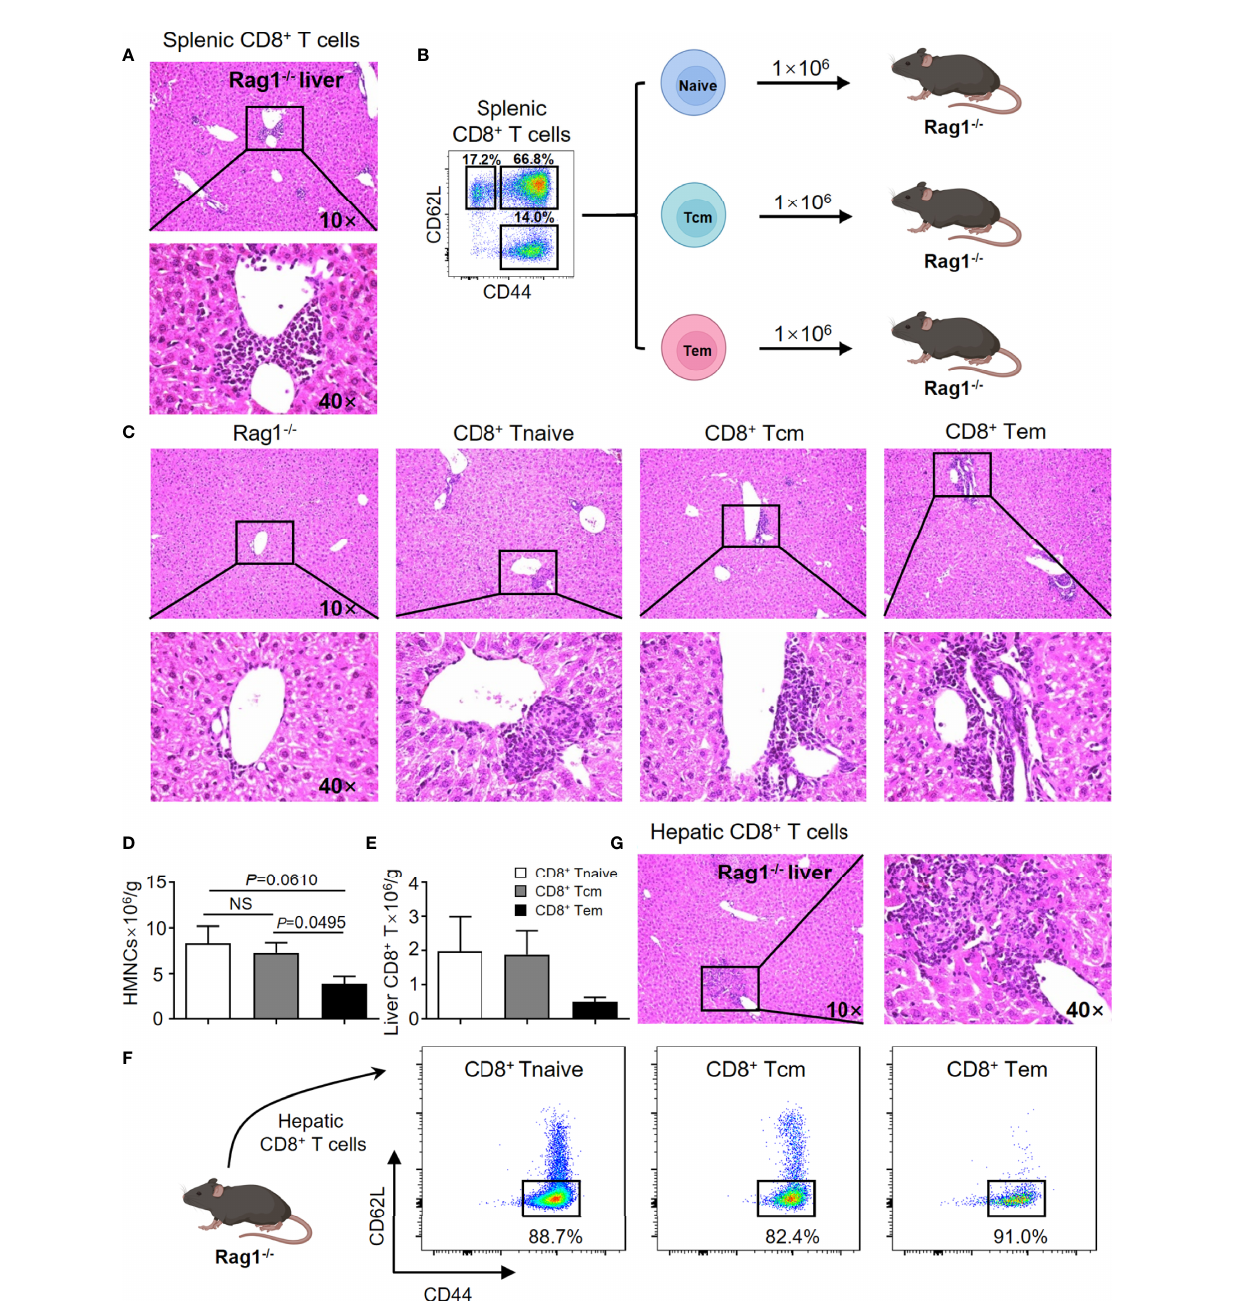
FIGURE 1 | CD8 + T cells are the key cells leading to the pathogenesis of PBC in the TG murine model. (A) Representative H&E staining of liver sections of Rag1 -/- mice that were recipients passively transferred splenic CD8 + T cells from TG mice. (B) Schematic representation of the adoptively transferred splenic CD8 + T subpopulations into Rag1 -/- mice. (C) Representative H&E staining of liver sections of Rag1 -/- mice that were recipients of passively transferred splenic CD8 + T subpopulations from TG mice. (D) Number of hepatic mononuclear cells of recipients, data are presented as mean ± SEM. (E) Number of hepatic CD8 + T cells of recipients, data are presented as mean ± SEM. (F) Representative components of hepatic CD8 + T cells of Rag1 -/- mice that were recipients of passively transferred splenic CD8 + T cells from TG mice. (G) Representative H&E staining of liver sections of Rag1 -/- mice that were recipients of passively transferred hepatic CD8 + T cells from TG mice. NS, No signi fi